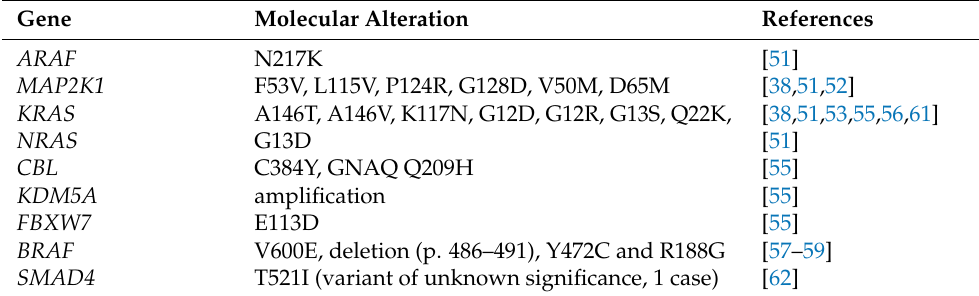
Table 2. Certain gene mutations identified in RDD